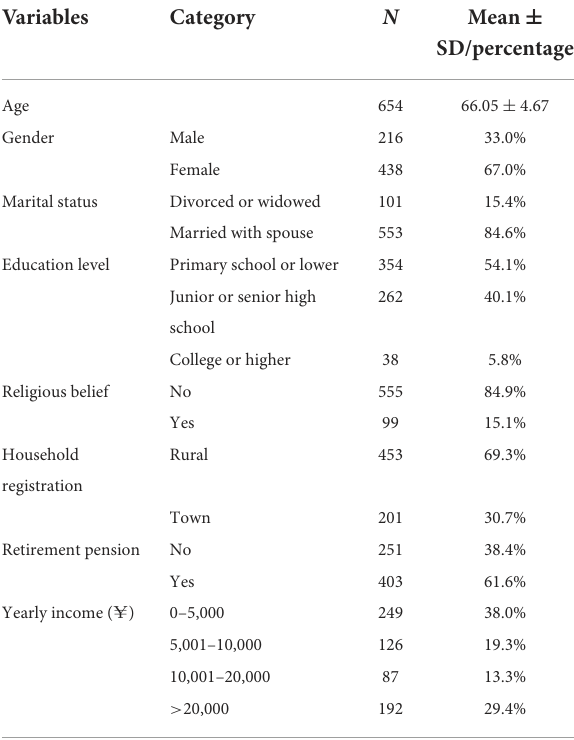
stress and resilience in the relationship between loneliness and depression. The total effect of loneliness on depression was 0.398 ( p < 0.001). When perceived stress and resilience entered